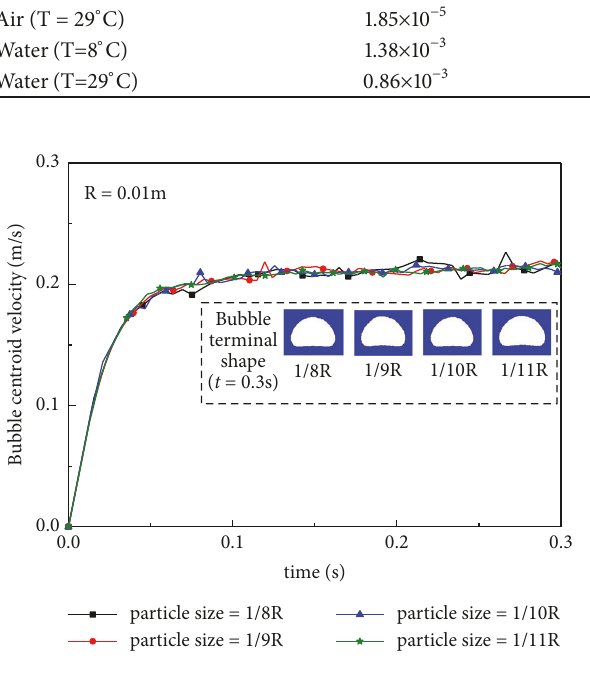
Figure 2: Particle size sensitivity analysis ( Re = Bo =10).